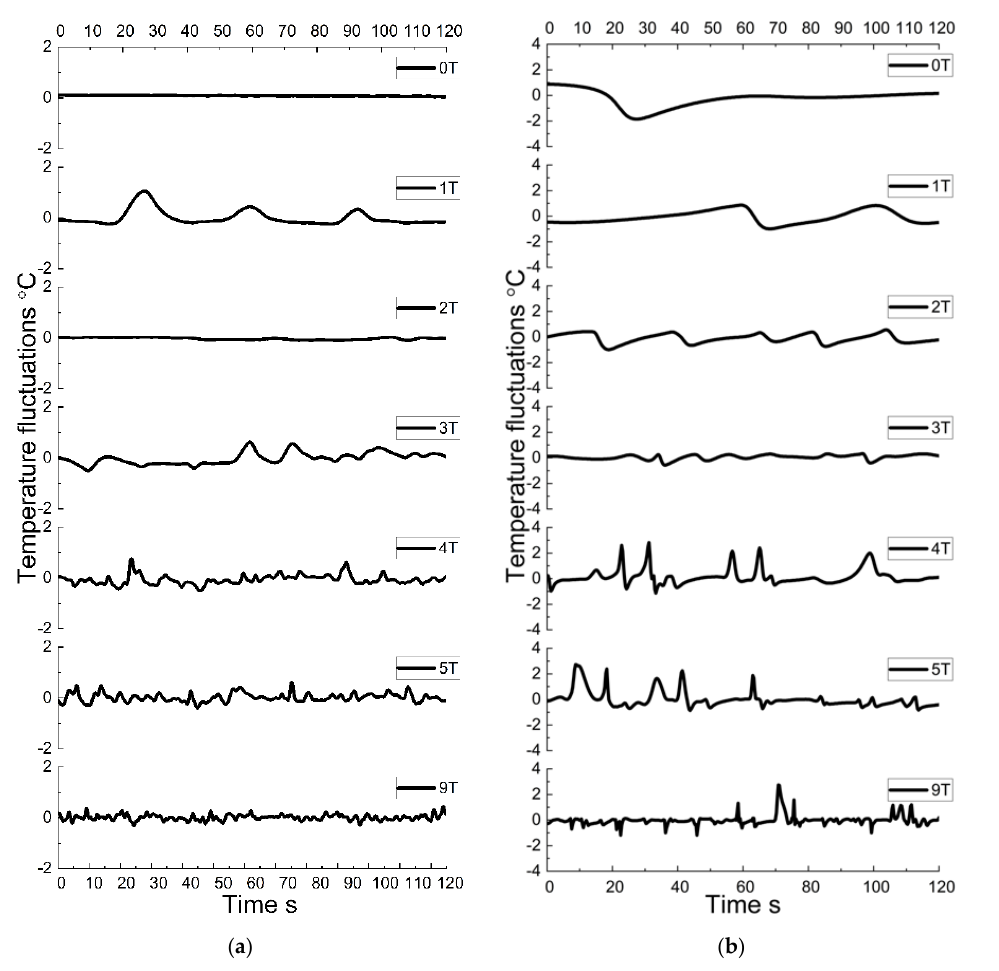
Figure 5. Temperature fluctuations for the case with ΔT = 11 °C—( a ) experimental and ( b ) numerical. In natural convection cases the temperature lines are flat and only in the numerical Δ T = 11 °C case does the line show single slow fluctuation. The thermal Rayleigh number is 8.22 × 10 4 for the smaller temperature difference and 2.21 × 10 5 for the higher tempera- ture difference, which indicates that the flow is steady. The laminar and the studied en- closure have a dominant convection cell that fills a greater part of the enclosure. The same behavior is observed for Δ T = 5 °C and b 0MAX = 1T. A significant change occurs for the magnetic field induction of 2T for Δ T = 5 °C and b 0MAX = 1T in Δ T = 11 °C. The lines repre- senting the temperature changes become unstable and small, periodic fluctuations can be observed. Those fluctuations alone may suggest that a thermal plume is slowly arising from the heated wall—a process where hot fluid from the bottom has to rise up and an interplay emerges between the two forces: the buoyancy effect that tries to push the hot fluid upward and the inertia effect induced by the convective cell that opposes an upward motion. This phenomenon is clearly visible in Section 6.2, which will be discussed later. According to [42], three regimes can de distinguished based on the thermo-magnetic Rayleigh number: transient regime (Ra TM ≤ 3 × 10 7 ), a regime where the thermo-magnetic mechanism dominates (3 × 10 7 < Ra TM ≤ 3 × 10 8 ), and an additional wall heat transfer regime for Ra TM ≥ 3 × 10 8 . Therefore, the fluctuations in temperature signals ( b 0MAX = 2T for Δ T = 5